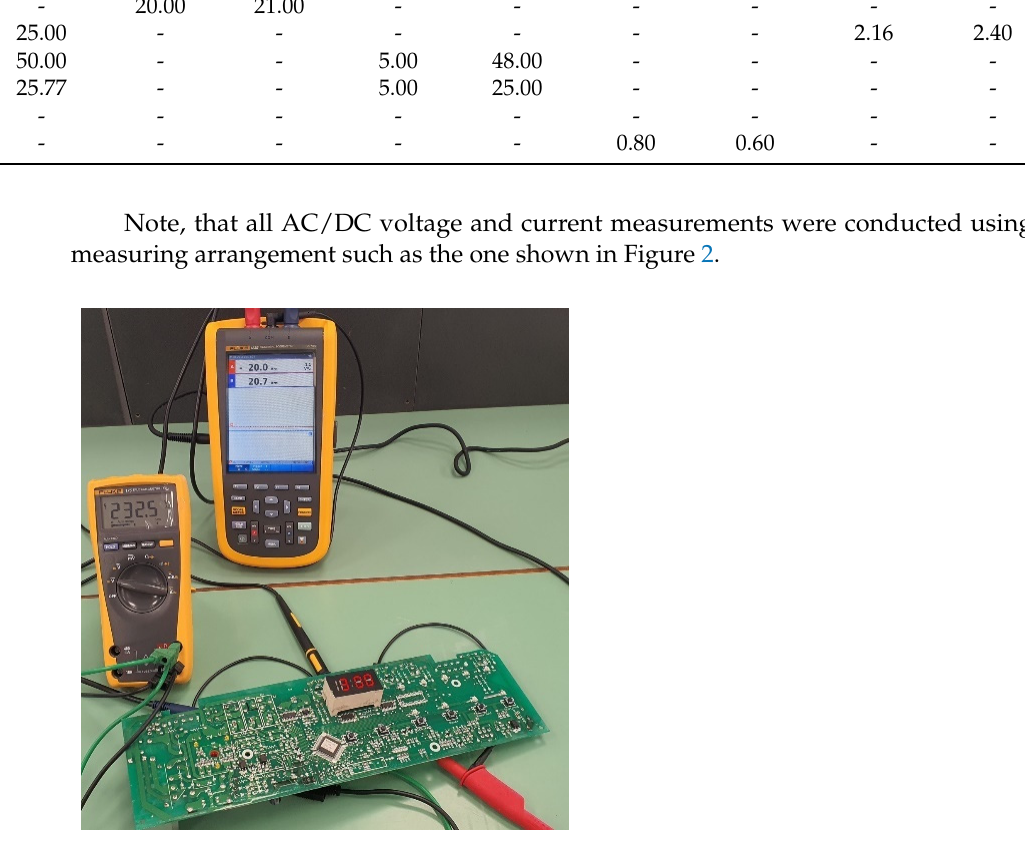
Figure 2. Experimental arrangement for AC/DC voltage and current measurements considering a PCB of a washing machine. Table 6. Failure rate values for PCB components.